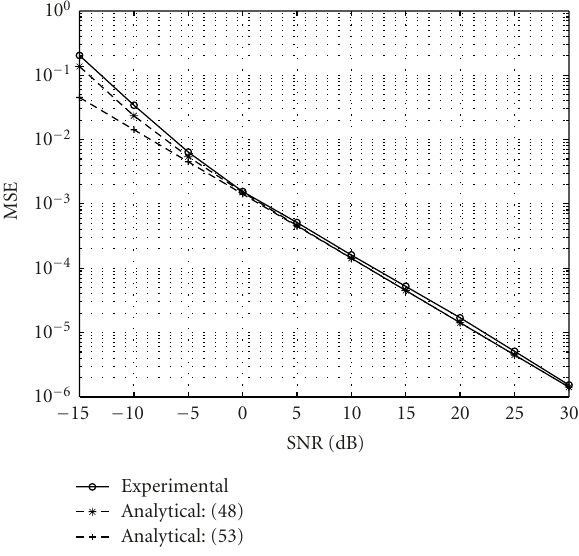
Figure 2: The MSE of the estimated channel versus number of data samples. The WP algorithm.